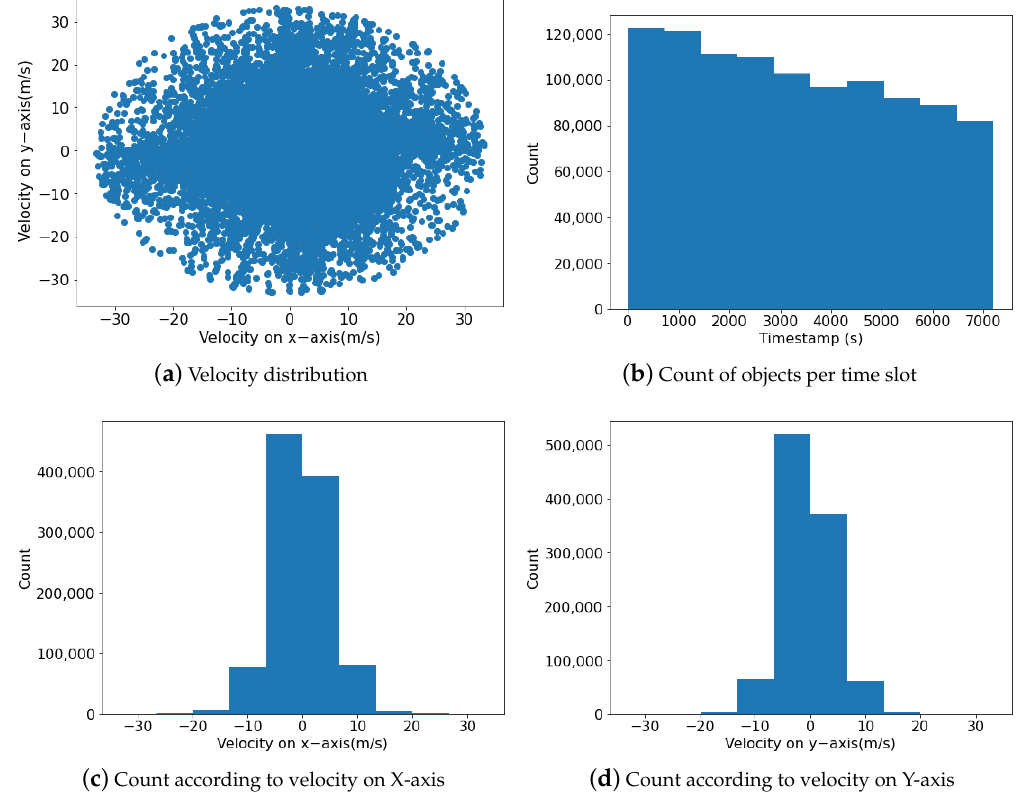
Figure 7. Distribution of different features of the